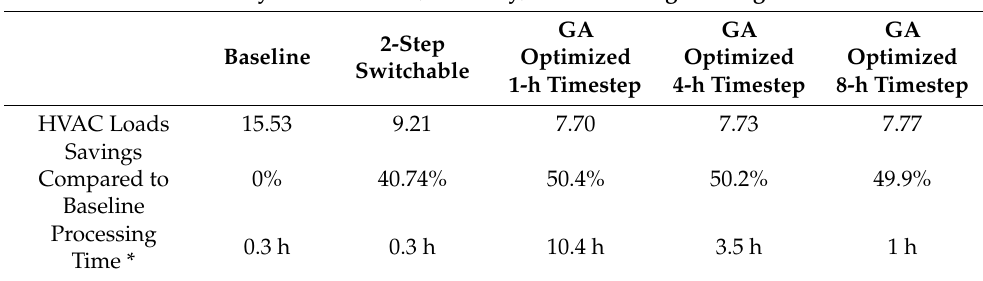
Table 12. Impact of time-step on optimization results for switchable shades applied to a house located in Golden, CO during 21st